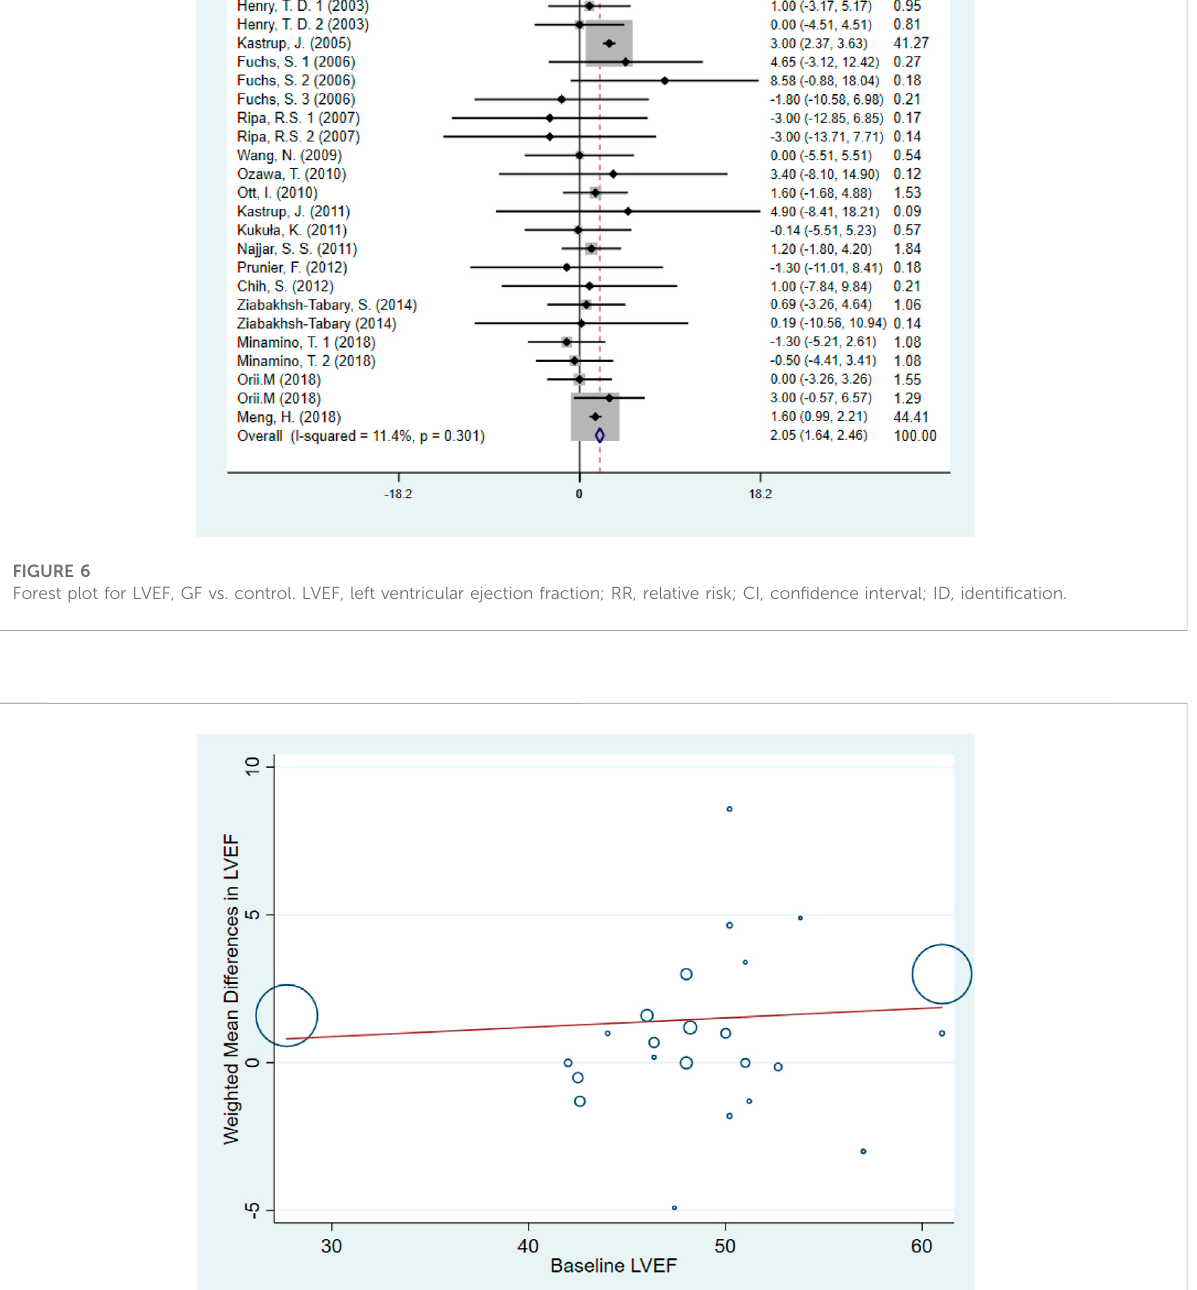
Frontiers in Cell and Developmental